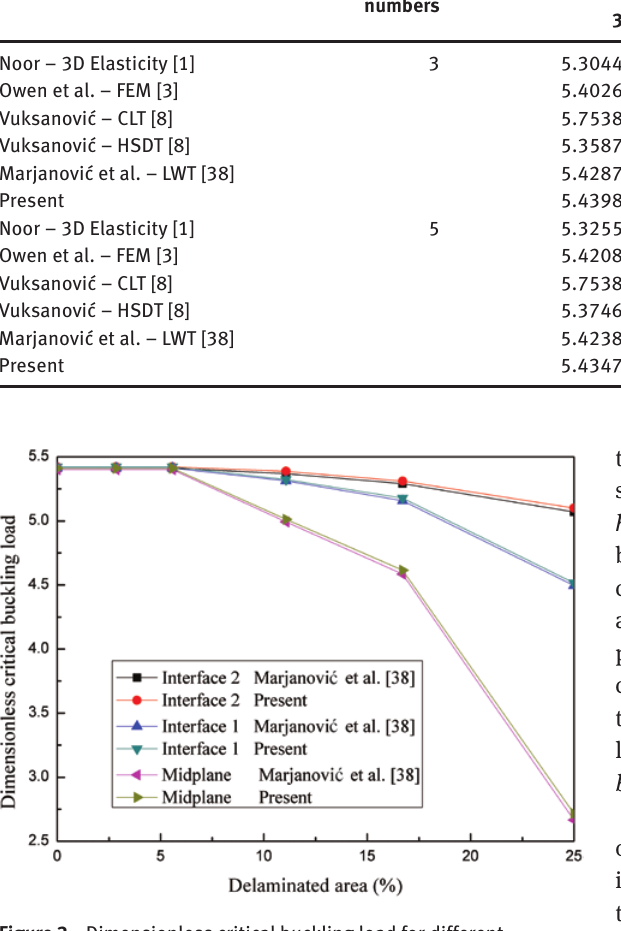
Figure 3: Dimensionless critical buckling load for different delamination locations and areas of